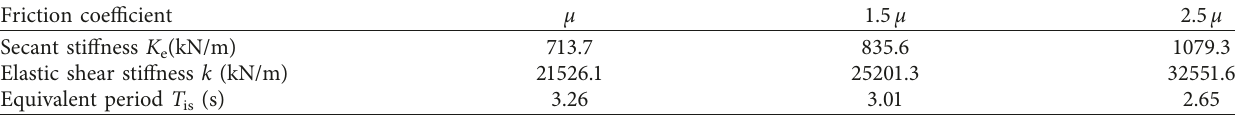
Table 4: Five columns frame: characteristics of central isolator.